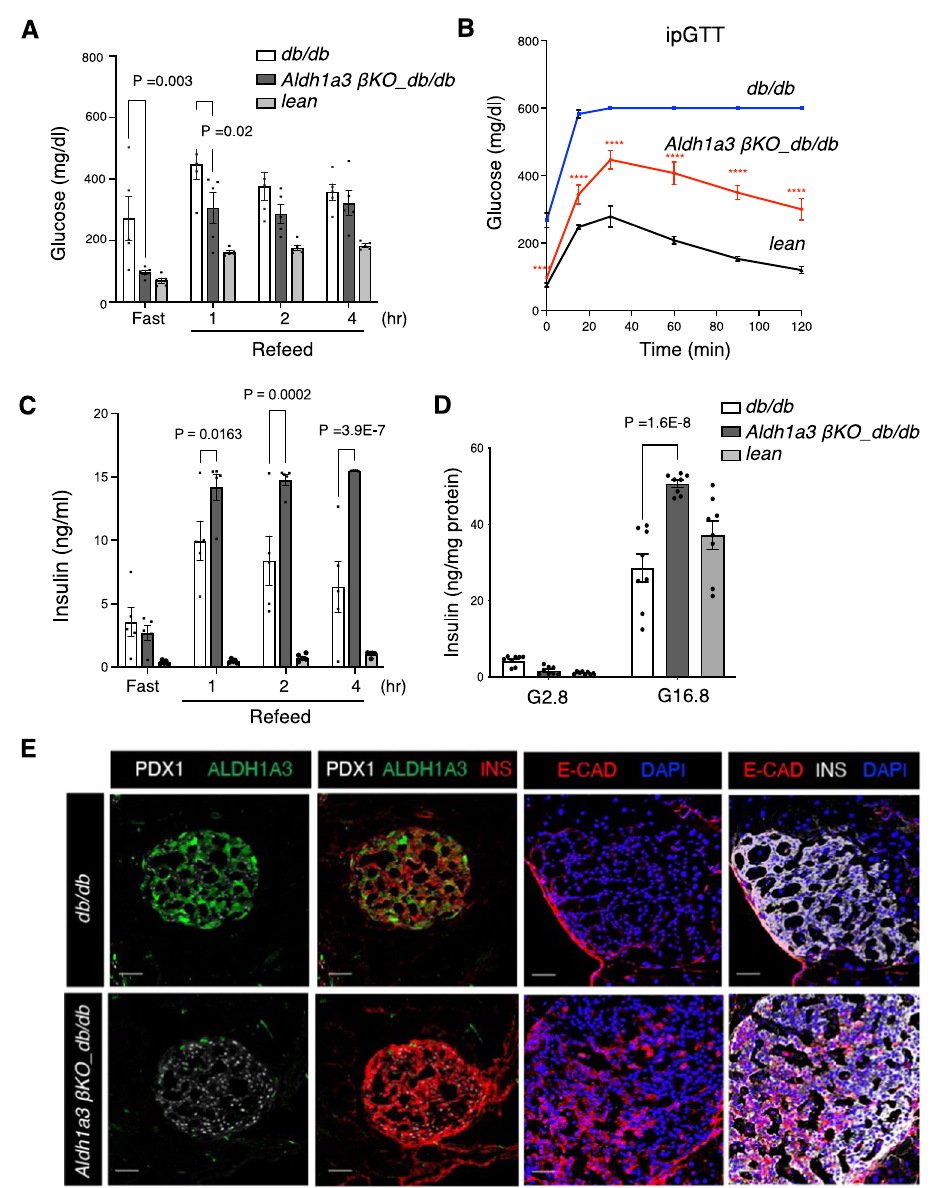
β -Aldh1a3 KO_ db/db , lean or db/db mice. ANOVA was performed between the two groups ( n =8 per group). E Immuno fl uorescent staining of PDX1, INS,